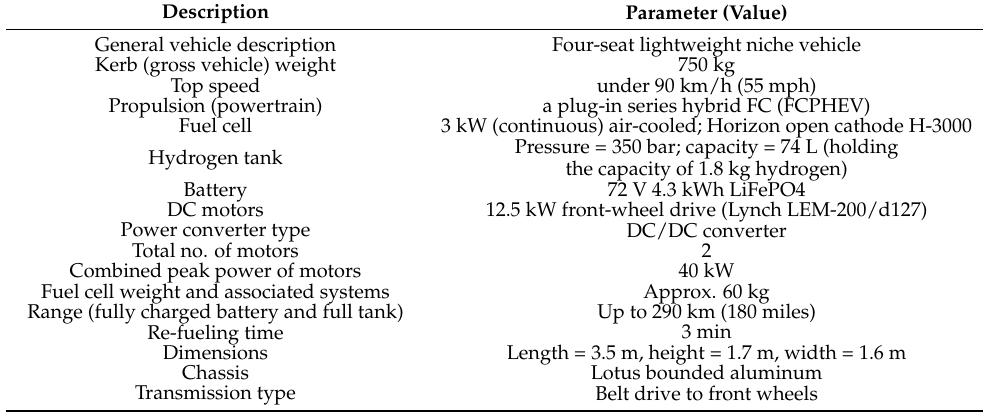
Table 1. Specifications of a fuel